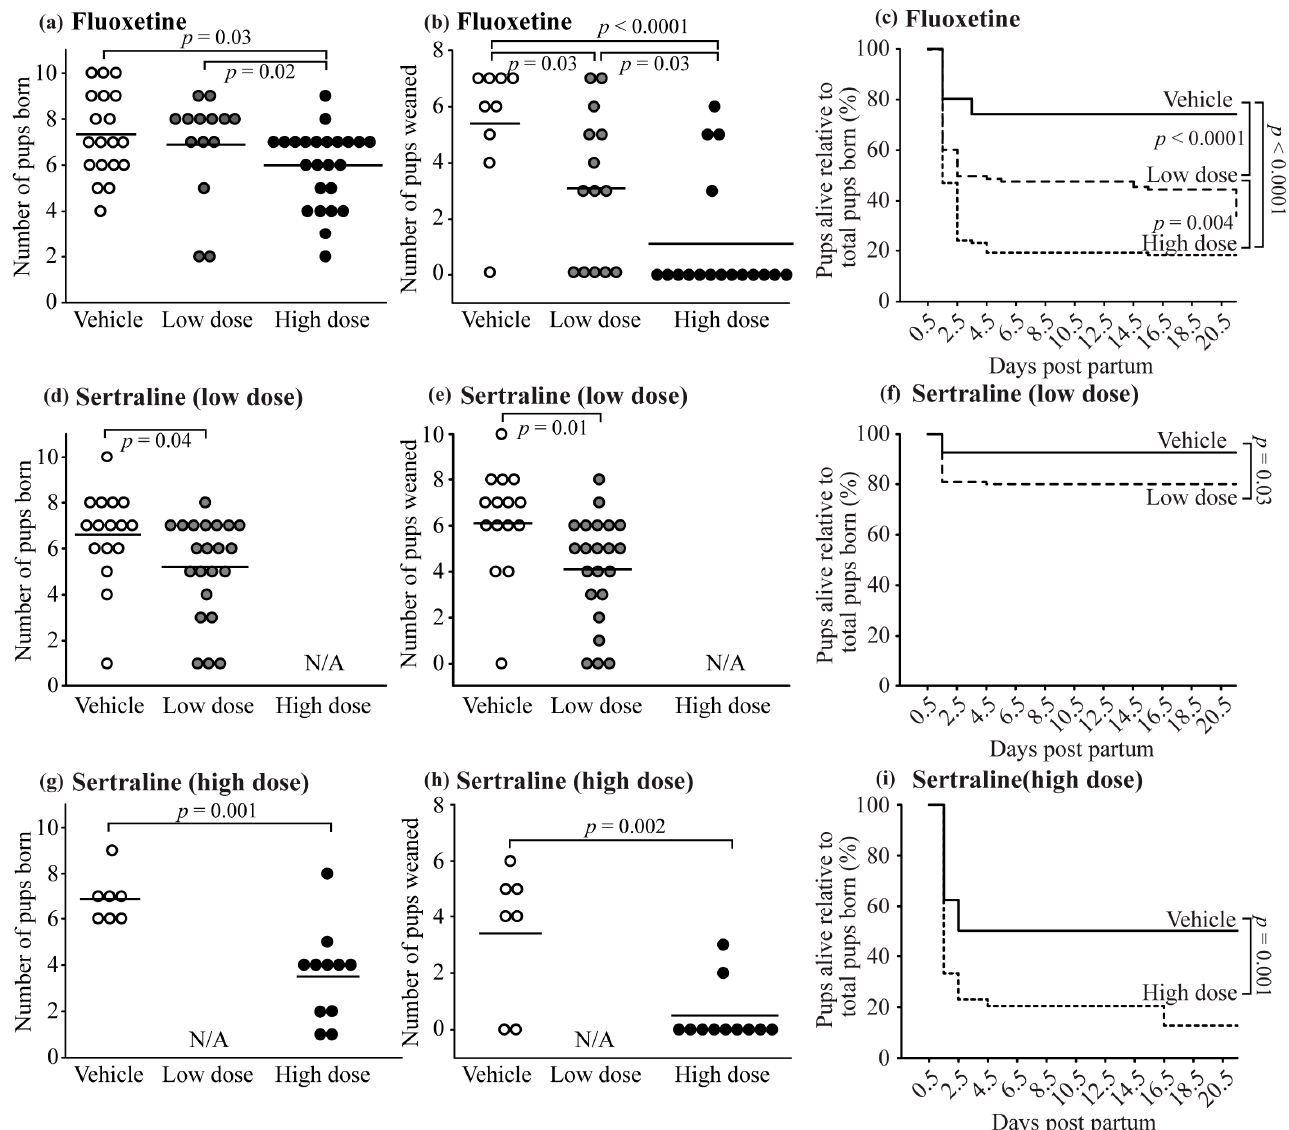
Figure 2. Effect of fluoxetine ( a – c ) and sertraline ( d – i ) on neonatal outcomes: Number of pups born per litter ( a , d , g ); number of pups weaned per litter ( b , e , h ). Survival analysis of pup mortality ( c , f , i ) during lactation (days postpartum 0.5 to 21.5).